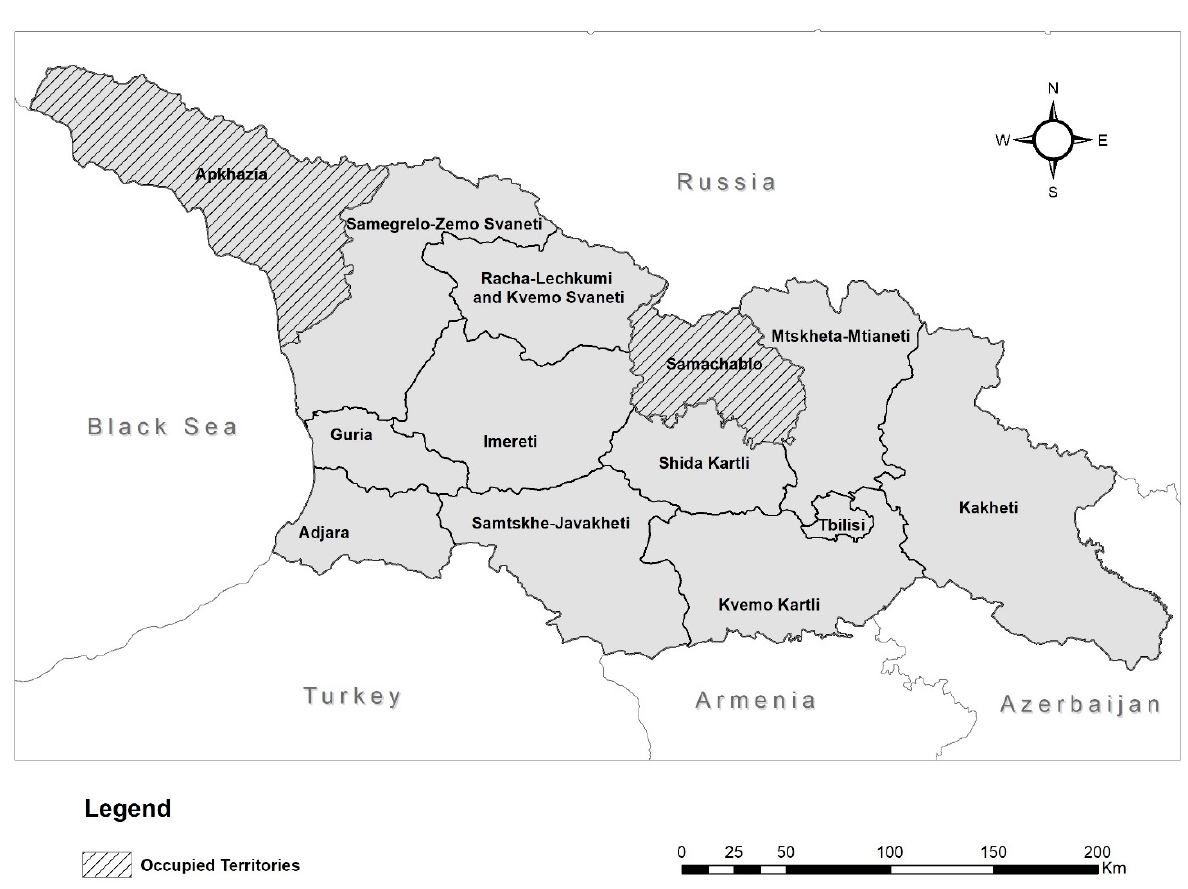
Figure 1. Map of Georgia showing its borders with neighbouring countries and the regions within Georgia.